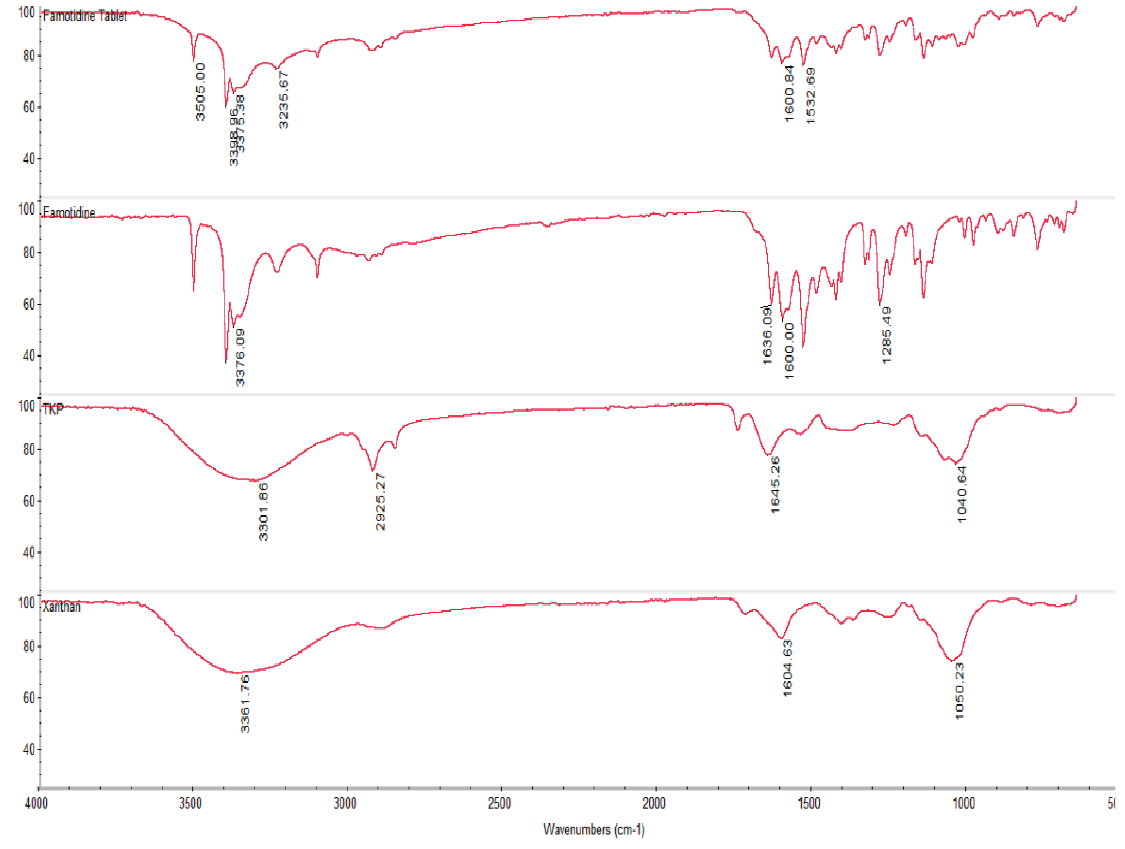
Figure 8. FTIR spectroscopy of pure famotidine, TKP, xanthan and crushed optimum matrix tablet of